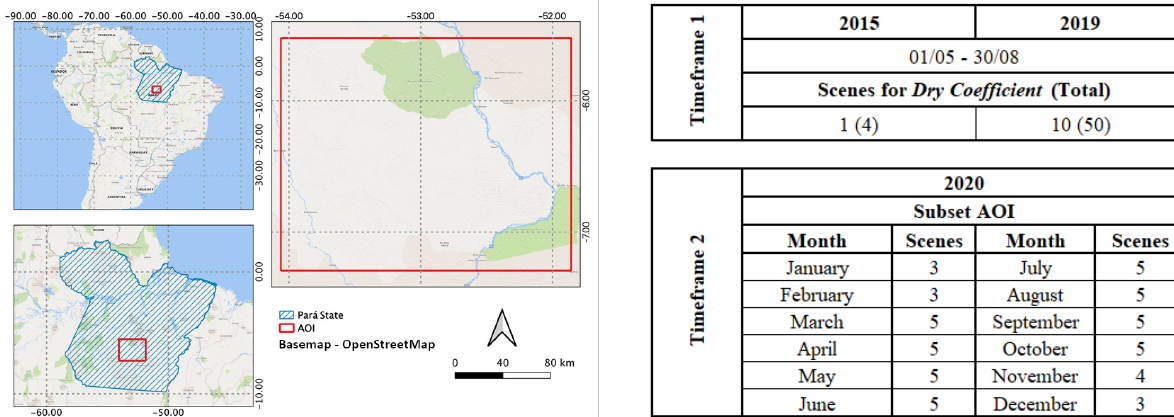
Figure 1. Area of interests - Para State,